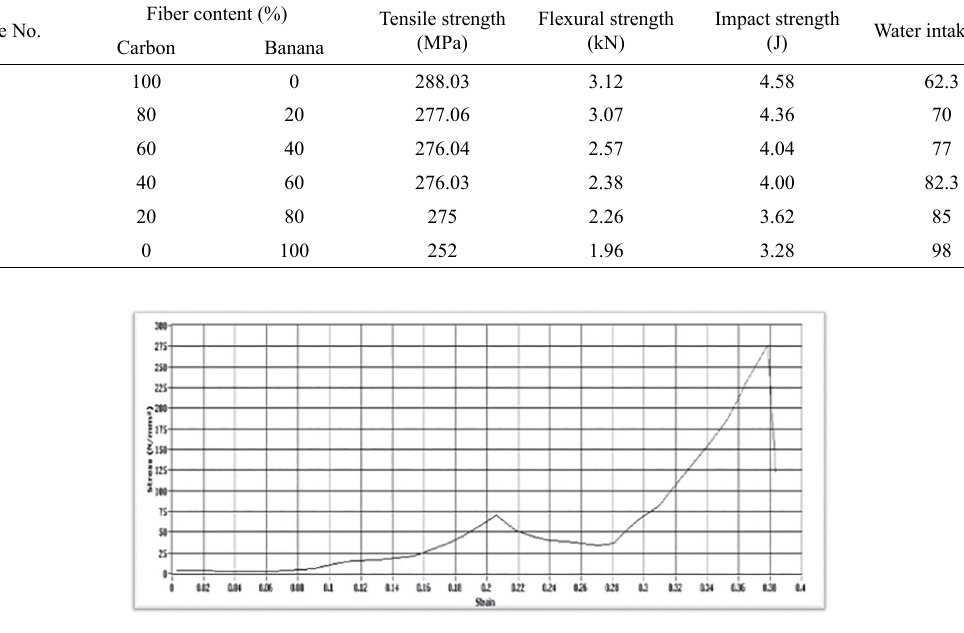
Figure 7: Typical stress vs. strain curve generated from UTM during tensile loading